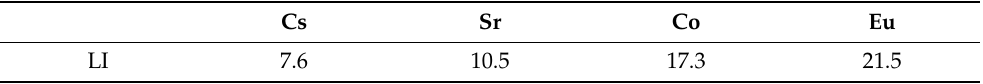
Table 4. Leachability indices (LIs) for nuclides (Cs, Sr, Co, and Eu) from the solidified cement specimens.